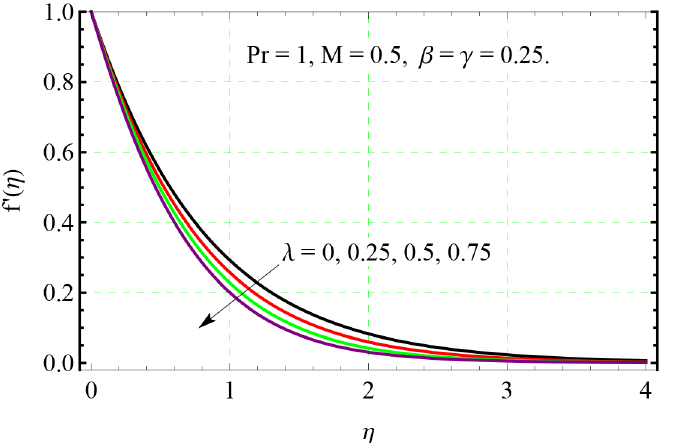
Fig 5. Effect of λ on f 0 ( η